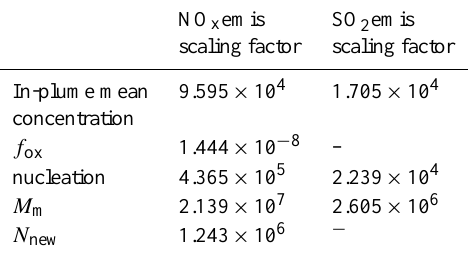
Table 5. Emission scaling factors used in the P6 parameteri- zation for determining effective SO 2 and NO x concentrations (Eqs. 1 and